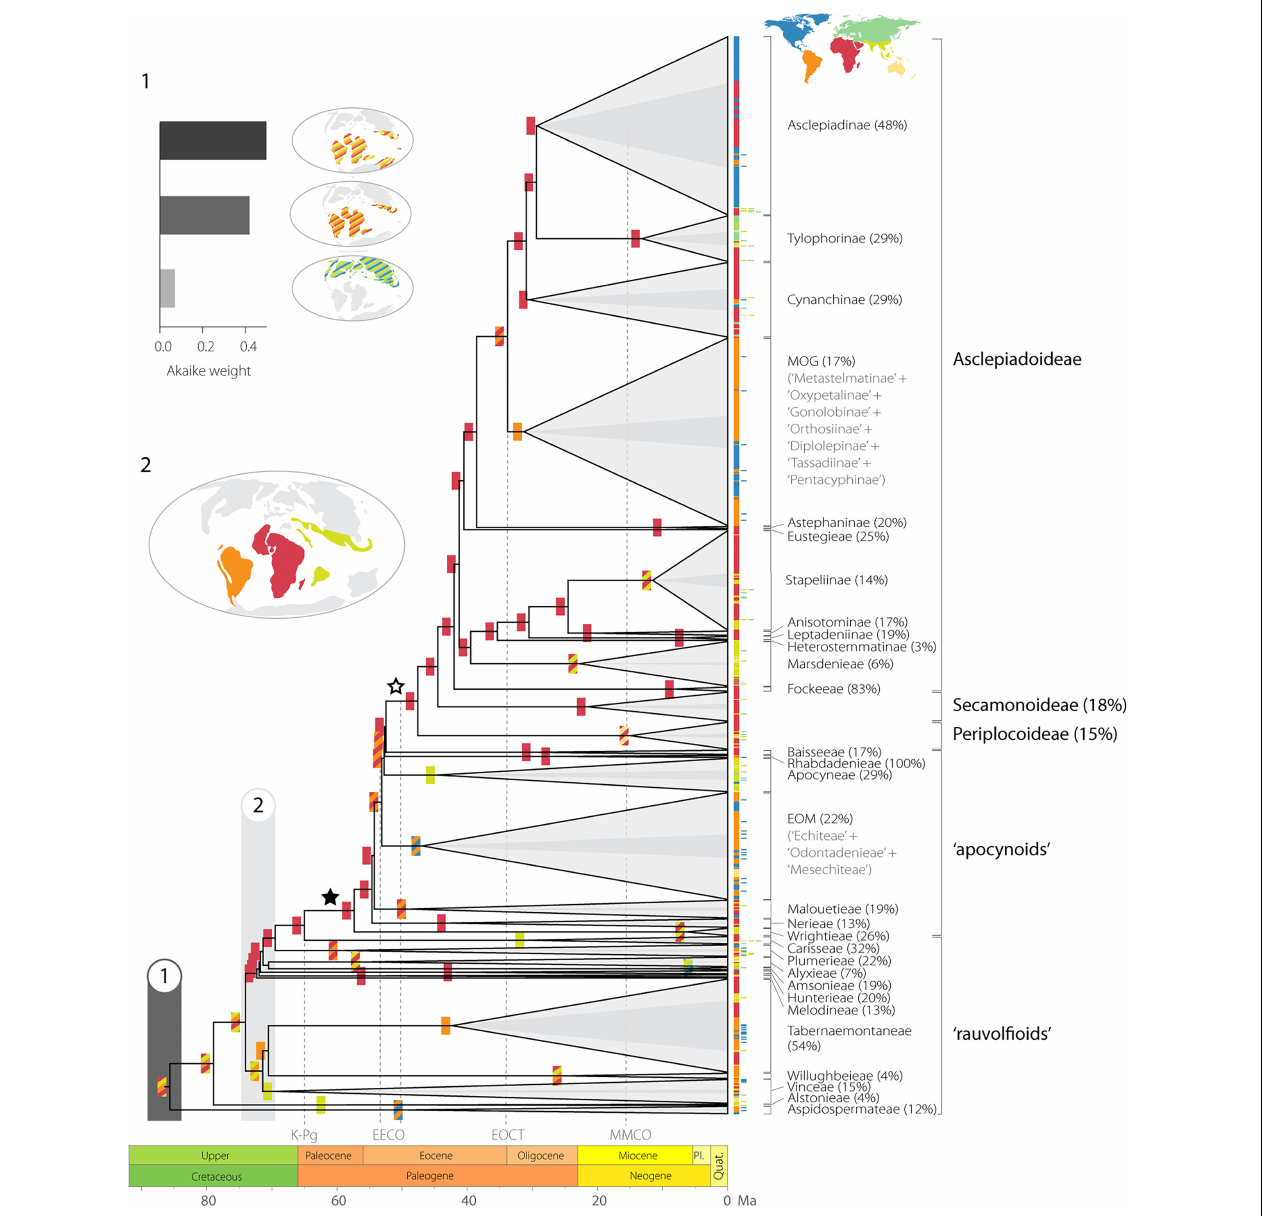
FIGURE 3 | Historical biogeography of Apocynaceae. Colored boxes at the tree nodes indicate the most probable ancestral geographic range inferred by the best biogeographic model (out of 72: M1s-DEC, Akaike weight 0.92; Supplementary Table 2A ). Current distribution of species is given to the right of the tips following the color code in the map inset top right. Named clades according to Fishbein et al. (2018) are collapsed and sampling fraction is given after the clade name. The superimposed triangles in darker gray are scaled to the proportion of the sampling fraction per clade. The filled star indicates the APSA clade and the open star the pollinia-bearing lineages. (1) Results of biogeographic hypothesis tests of the ancestral area of Apocynaceae showing the model fit (Akaike weight): Pantropical 2, Pantropical 1, and Laurasia ( Table 2 ). (2) The inferred ancestral distribution of Apocynaceae at around 72 Ma is indicated in the map. Pl., Pliocene; Quat., Quaternary; K-Pg, Cretaceous-Paleogene boundary; EECO, early Eocene climatic optimum; EOCT, Eocene-Oligocene climate transition; MMCO, middle Miocene climatic optimum.